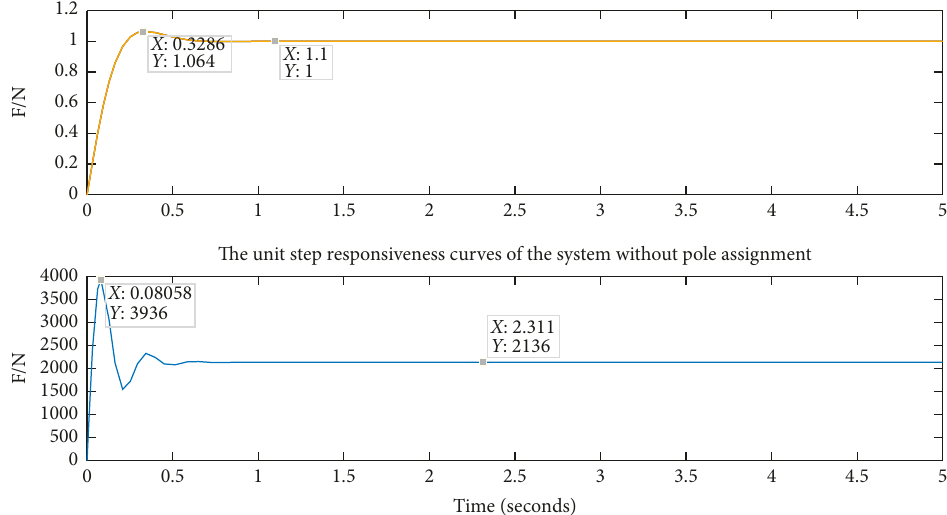
Figure 9: The unit step responsiveness curves of the system after the pole assignment and the system without pole assignment.